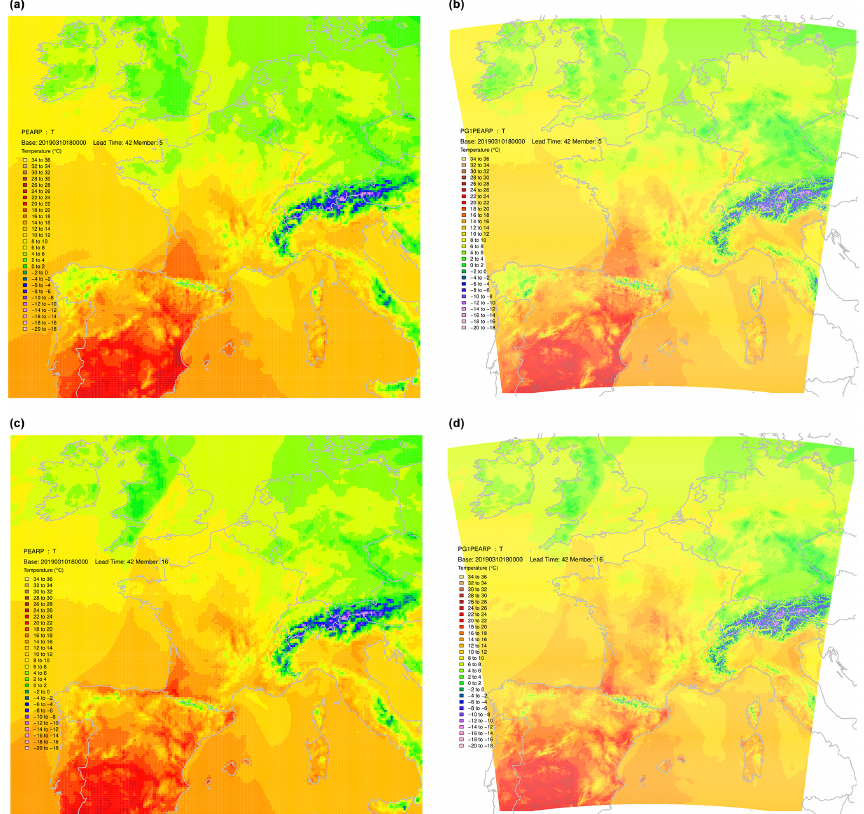
Figure 11. Raw PEARP member 6 temperature field (a) and the same after calibration, ECC and interpolation phase (b) together with raw (c) and post-processed temperature fields (d) for member 16. Note that the whole procedure can only be applied to the AROME